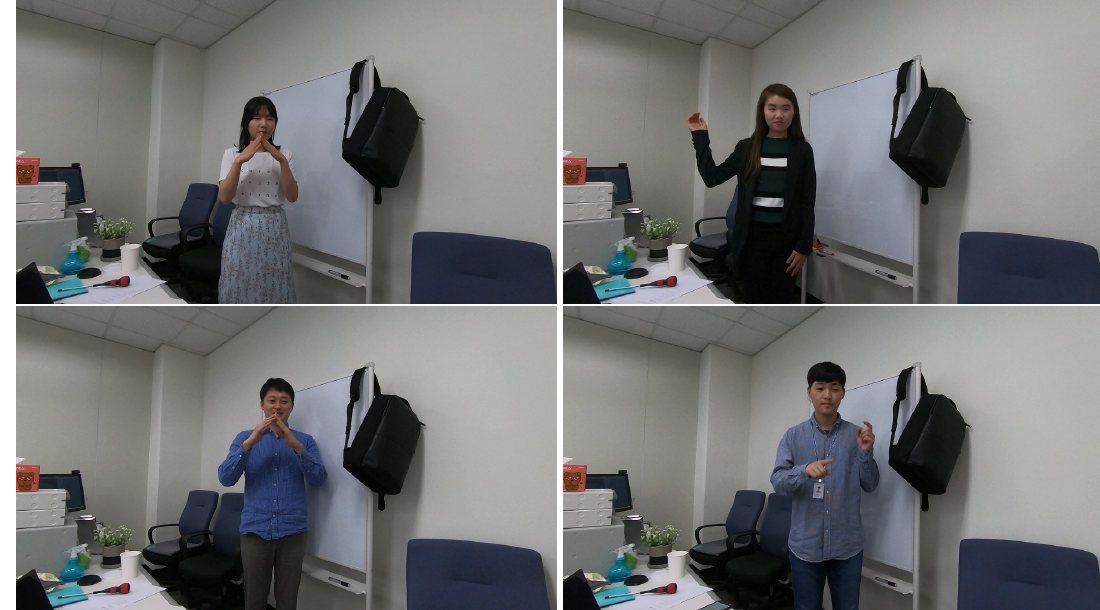
Figure 5. Example frames of additional test set videos recorded with cluttered background and non-expert signers.